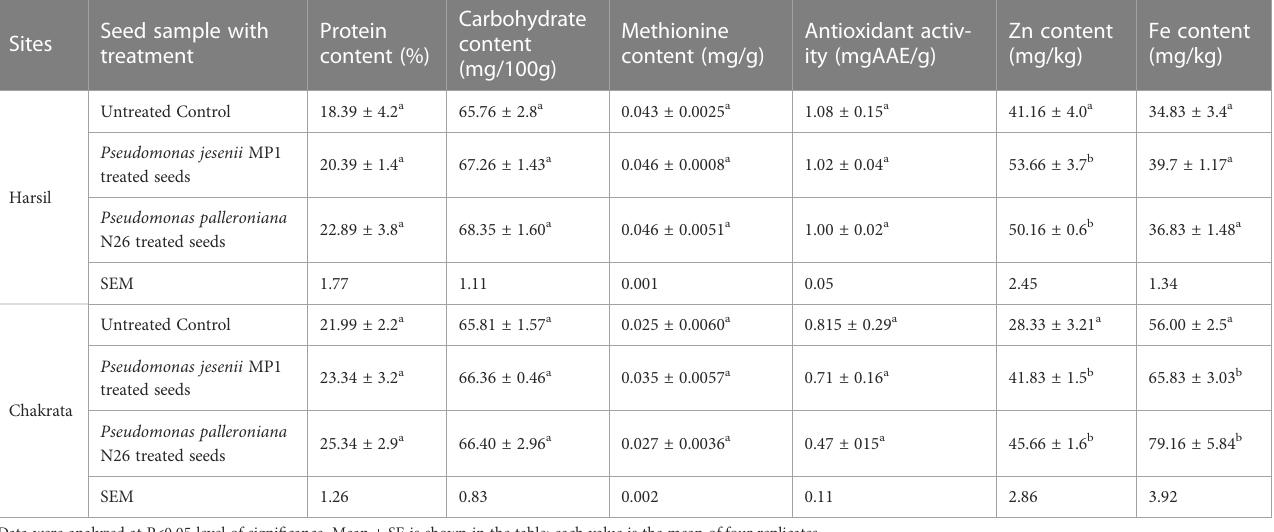
TABLE 3 Effect of Pseudomonas jesenii MP1 and Pseudomonas palleroniana N26 inoculation on nutrient status of Kidney bean at Harsil and Chakrata.